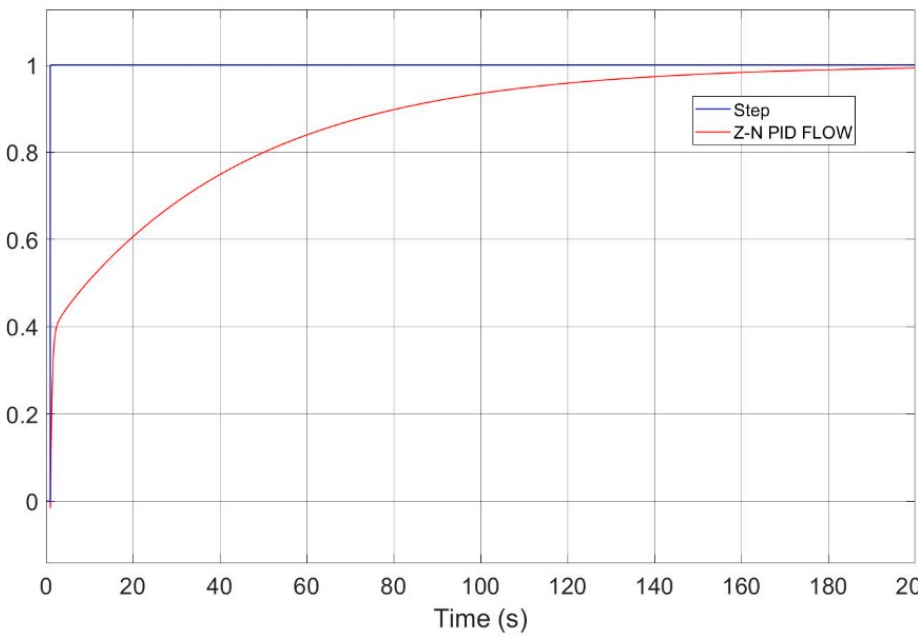
Figure 16. Flow versus time plot for PID tuned with Zeigler–Nicholas. Appl. Sci. 2020 , 10 , x FOR PEER REVIEW